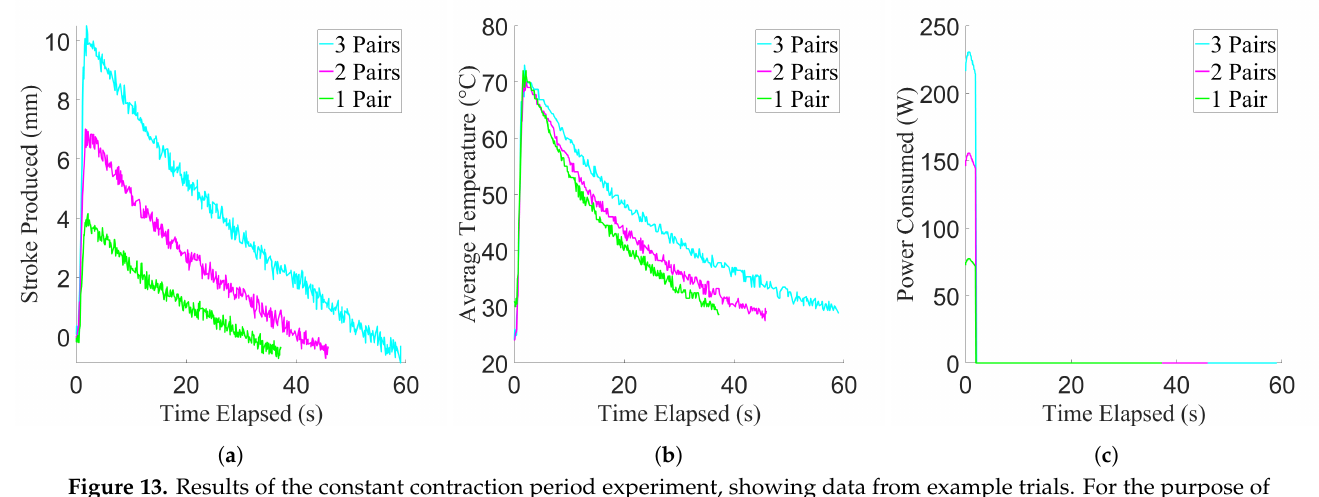
Figure 13. Results of the constant contraction period experiment, showing data from example trials. For the purpose of clarity, example curves were used, due to low variance between trials. ( a ) Stroke production of the actuator. ( b ) Temperature achieved by the actuator. ( c ) Power consumed by the